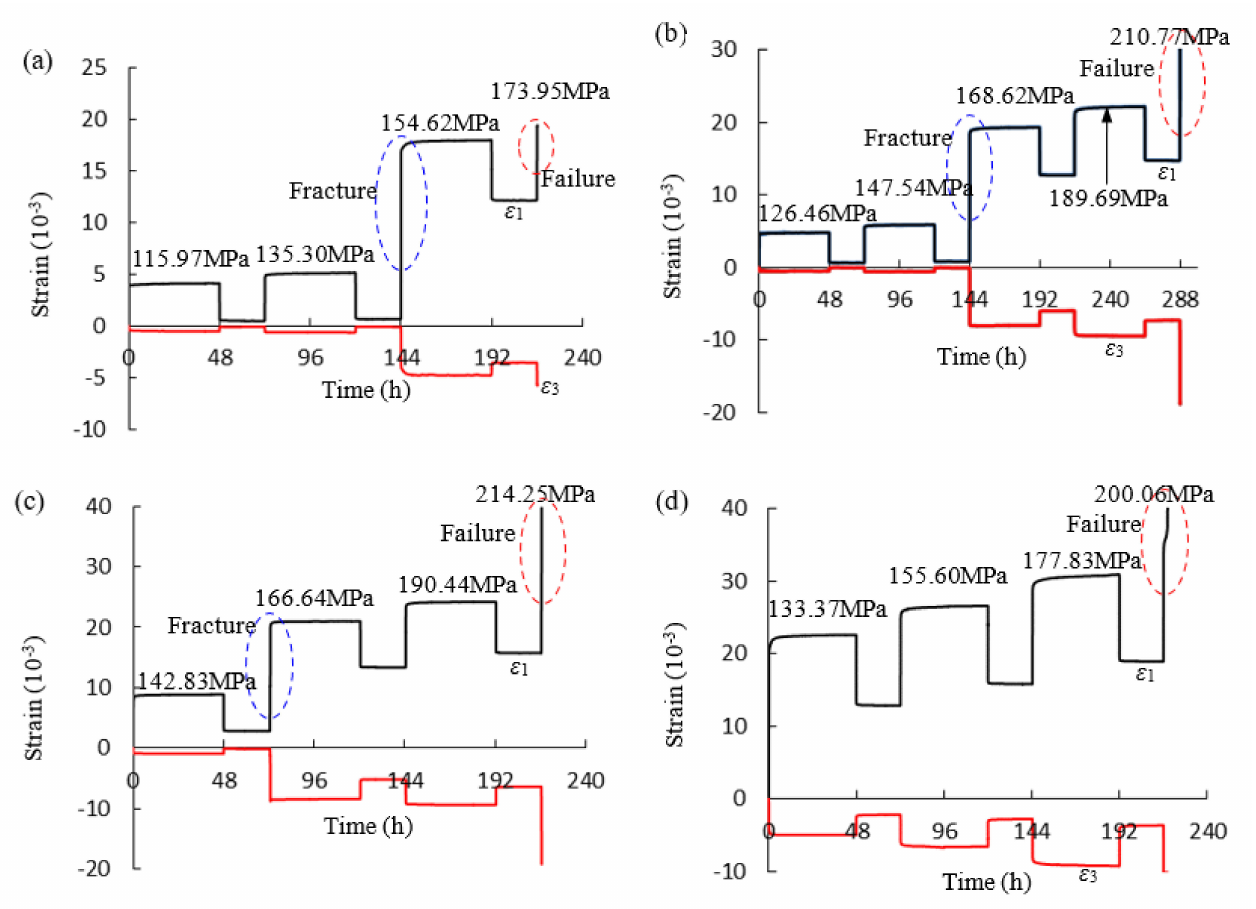
Figure 5. Axial and lateral strains of pre-cracked red sandstone specimen after undergoing different temperature